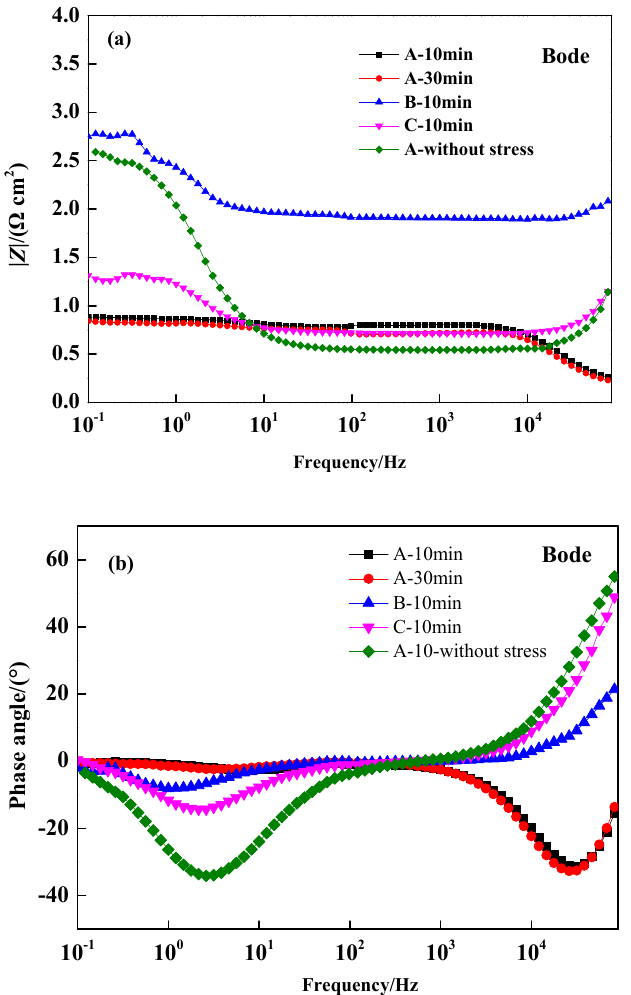
Figure 4. Bode curves of steel wires immersed in NH 4 SCN solution: impedance modulus ( a ) and impedance angle ( b ).